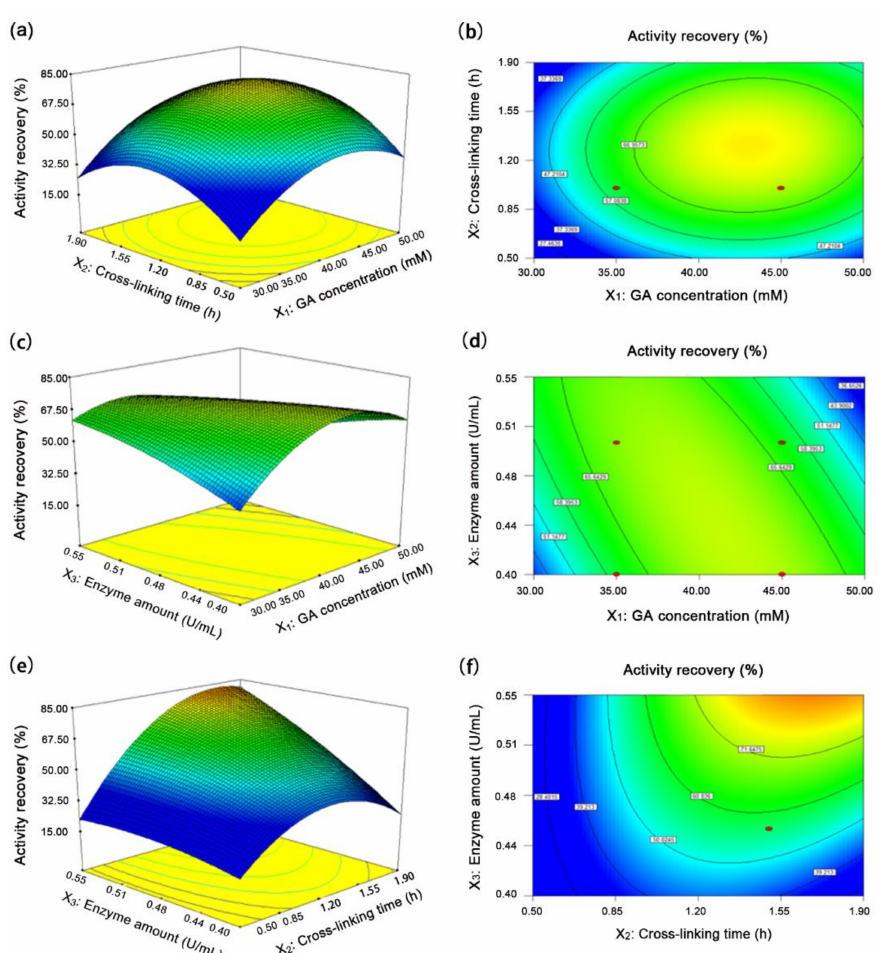
Figure 3. Three-dimensional (left) and two-dimensional (right) response surface plots of the interac- tion between different variables on activity recovery. ( a , b ) the effects of glutaraldehyde concentration and cross-linking time on activity recovery; ( c , d ) the effects of glutaraldehyde concentration and enzyme amount on activity recovery; ( e , f ) the effects of cross-linking time and enzyme amount on activity recovery. GA,